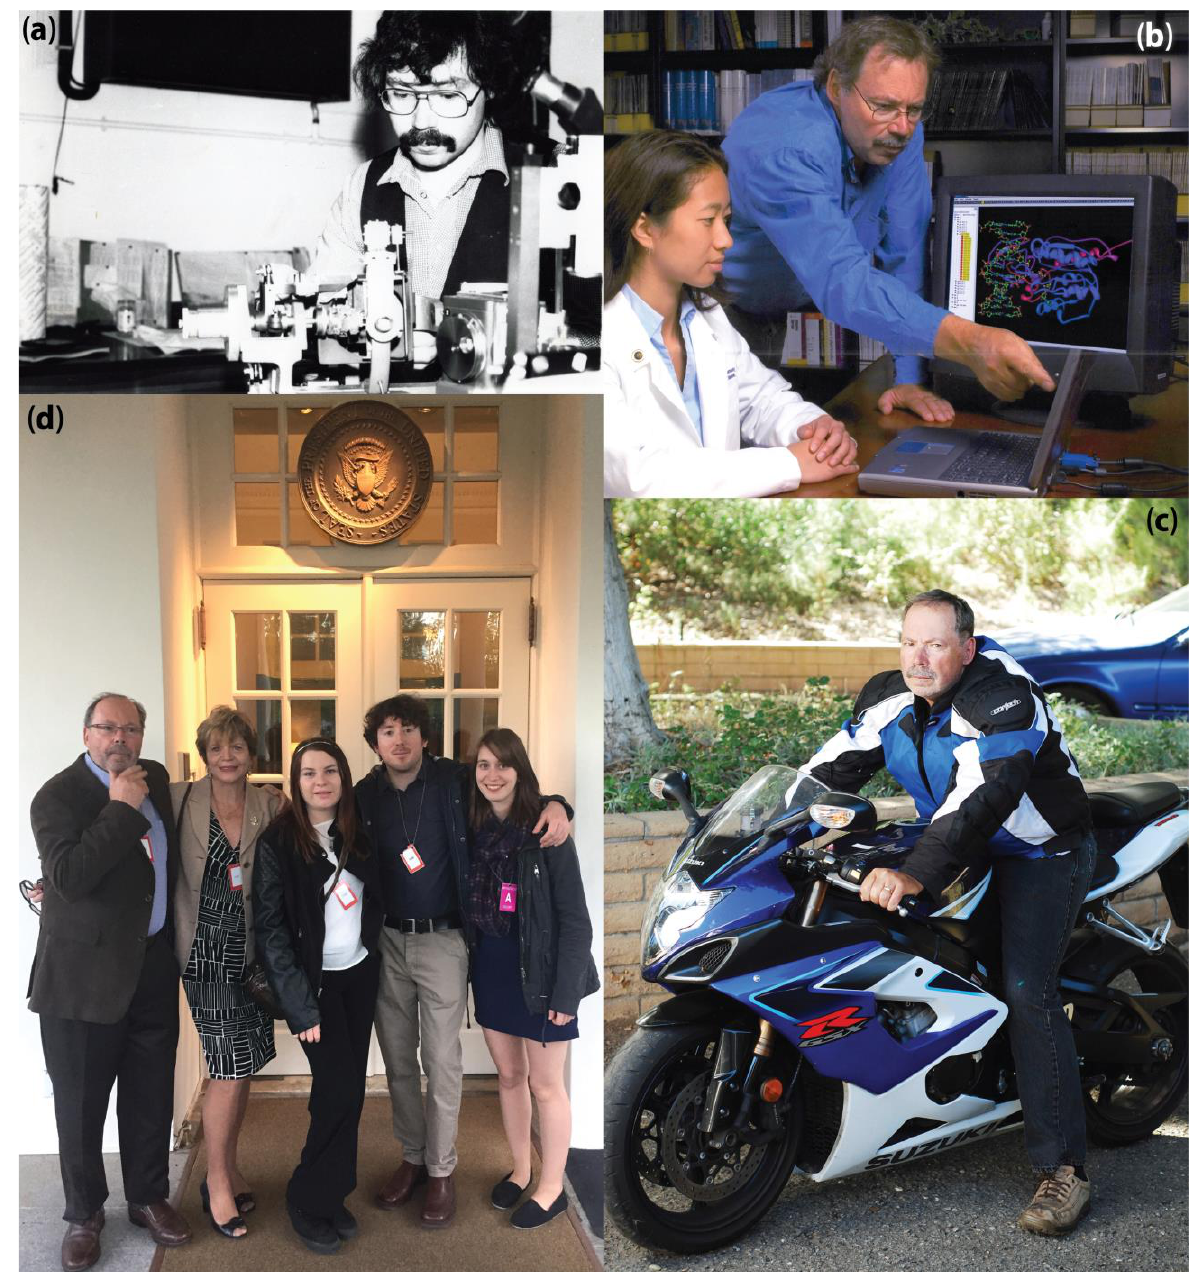
Figure 1. Phil’s life in science started ( a ) very hands on, progressed to ( b ) mentoring, and then he finally ( c ) took off for the ( d ) White House with his family. While he’s been a scientist for over 40 years, Phil’s been an avid cyclist for even longer; at UVA, he’s a founding member of the Hells Administrators (https://www.youtube.com/watch?v=ZgtNp1ditzE (accessed on 5 January 2023)).